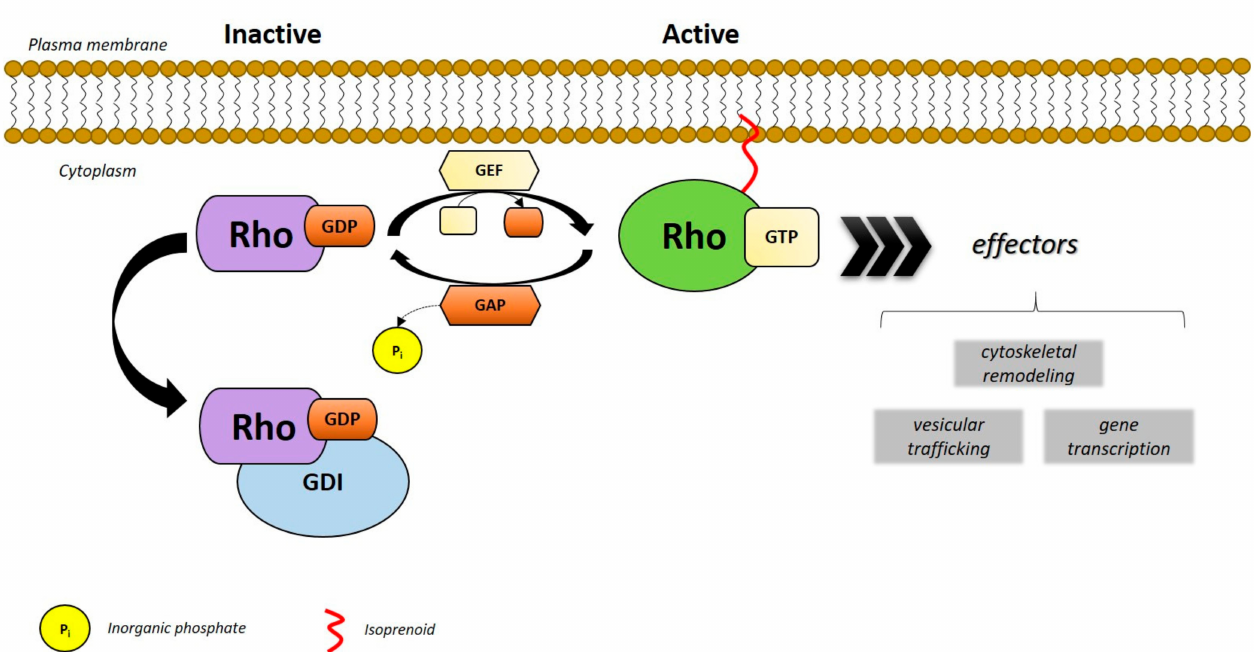
Figure 1. Activation of Rho proteins. Rho GTPases are known to act as “molecular switches” that cycle between an inactive (guanosine diphosphate-bound, GDP) and active (guanosine triphosphate-bound, GTP) forms, which are regulated by guanine nucleotide exchange factors (GEFs) and GTPase-activating proteins (GAPs). In their active form, Rho GTPases bind to effector molecules to generate a downstream response. Post-translational modifications, like the attachment of isoprenoid groups by geranylgeranyltransferases (GGTases), namely prenylation, allowed the proteins been targeted to the plasma